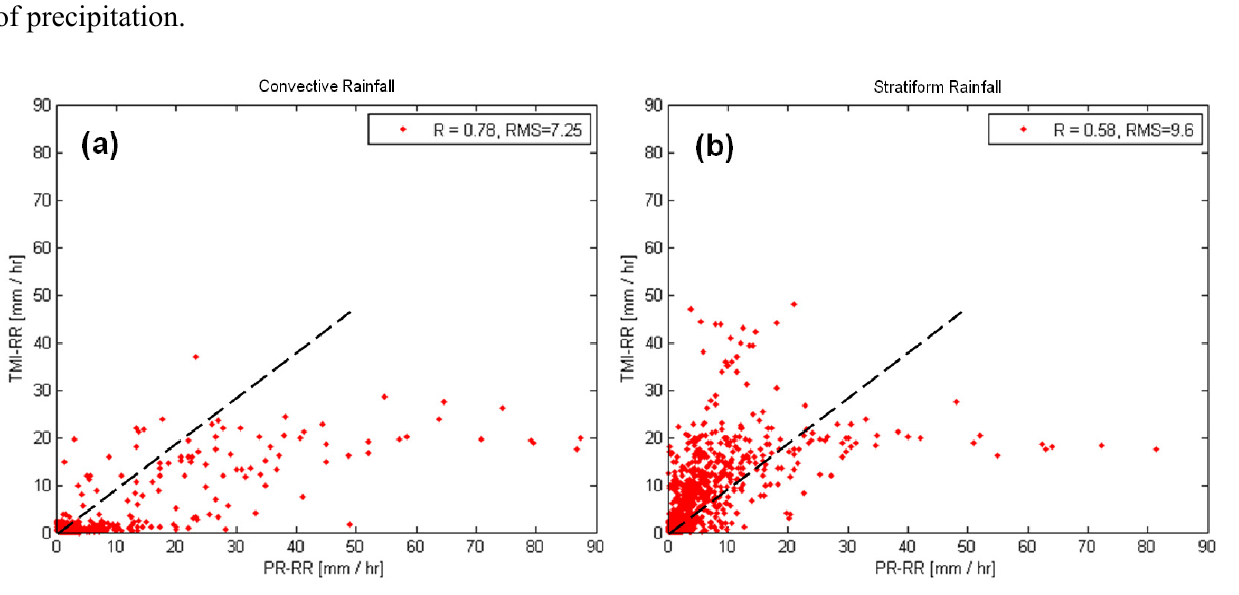
Figure 15. Scatterplot of TMI-RR and PR-RR for ( a ) convective rainfall and ( b ) stratiform